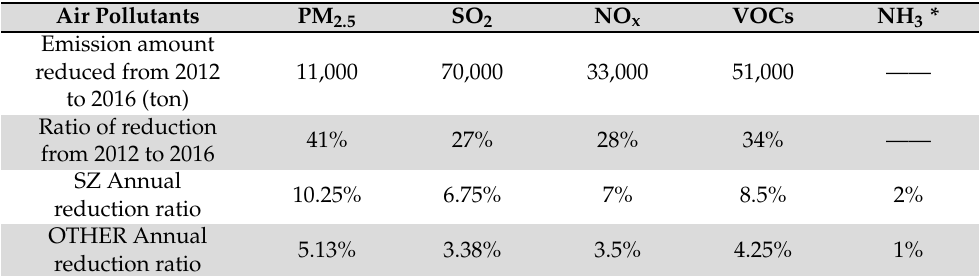
Table 2. Reduction ratio of air